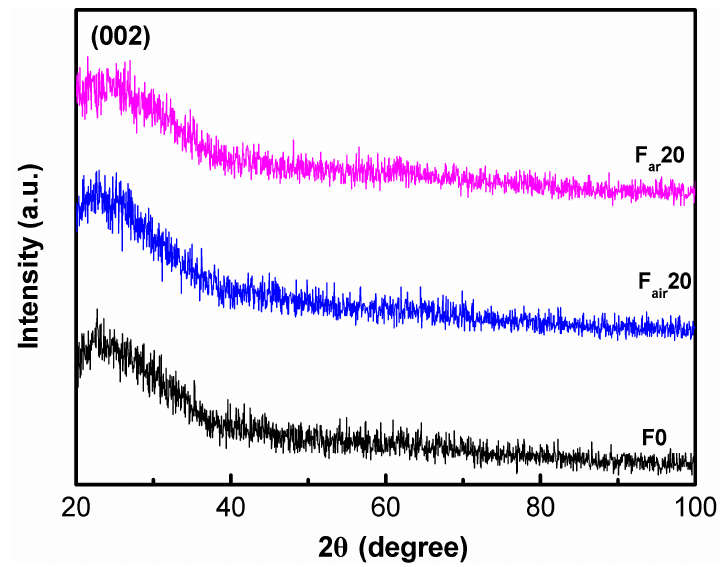
Figure 6. XRD spectra of F0, F air 20 and F ar 20.